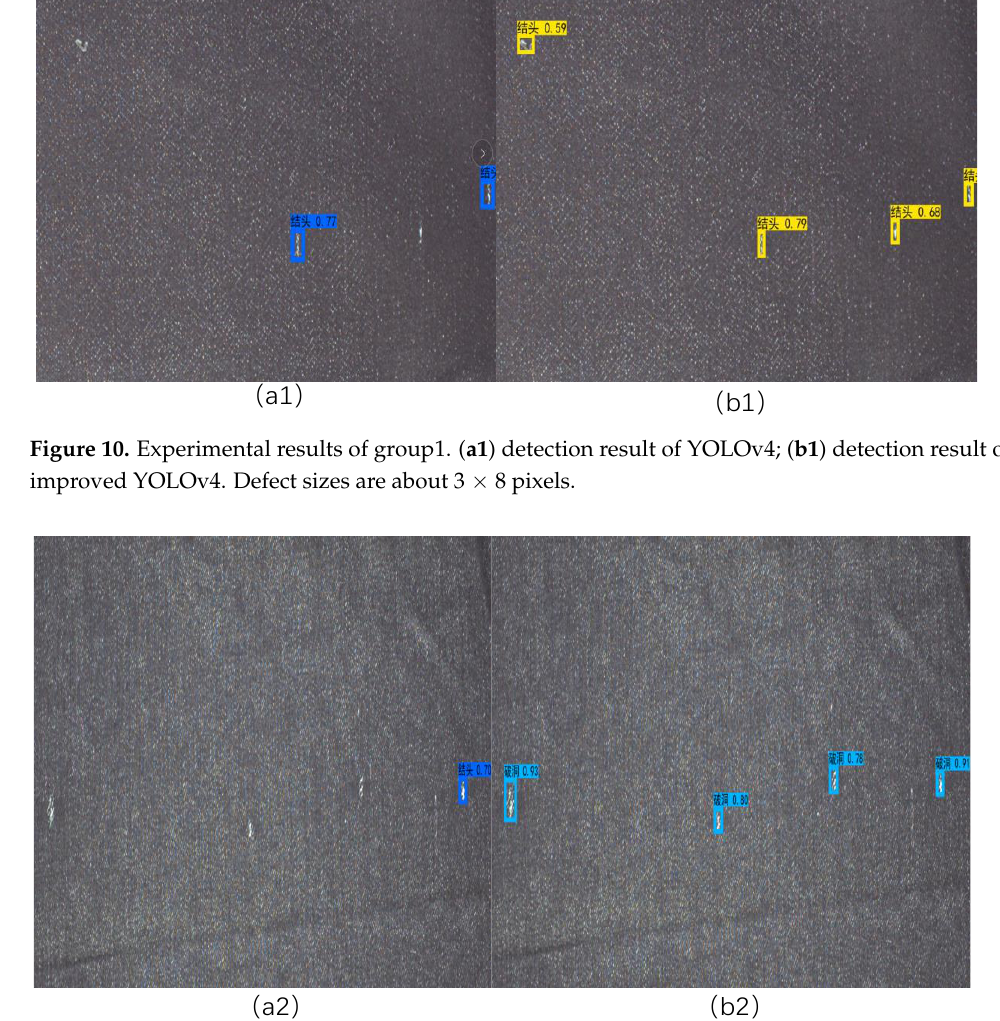
Figure 10. Experimental results of group1. ( a1 ) detection result of YOLOv4; ( b1 ) detection result of improved YOLOv4. Defect sizes are about 3 × 8 pixels.